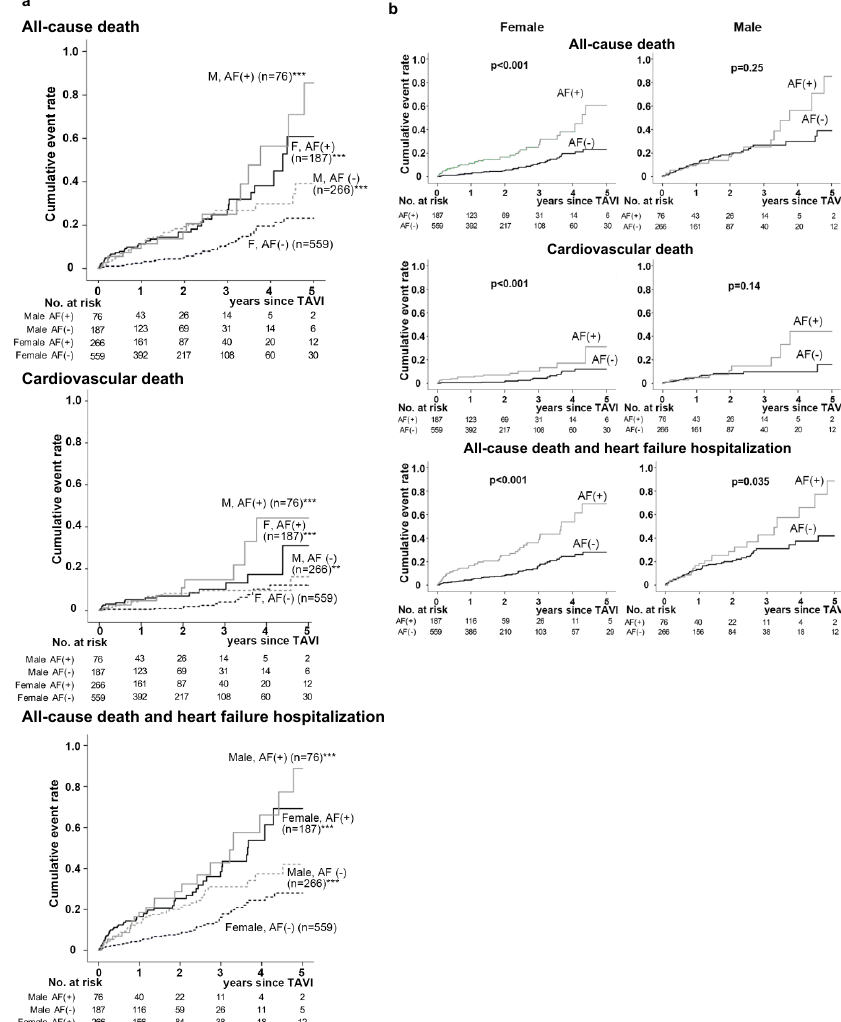
Figure 2. Cumulative incidence of adverse outcomes following TAVI in the 4 study groups according to gender and AF ( a ), and those in patients with and without AF, female and male ( b ). ( a ) cumulative incidence of all-cause and cardiovascular mortality and the composite of all-cause mortality with heart failure hospitalization in the Female AF(-), Male AF(-), Female AF(+) and Male AF(+) groups. ** and *** indicate p < 0.001 and < 0.0001 in log-rank test of Kaplan-Meier curves compared to that of the Female AF(-) group. ( b ) Kaplan-Meier curves of patients with and without AF (AF (+) and AF (-)) are separately drawn for females and males.